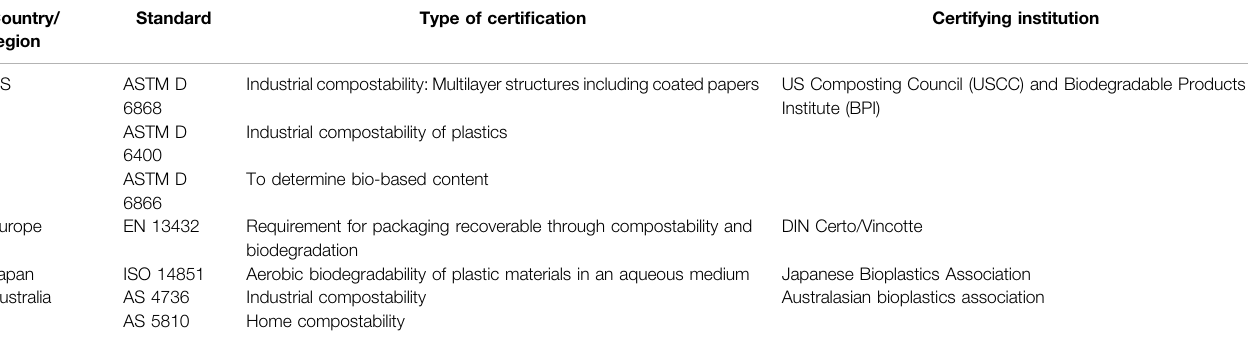
TABLE 1 | List of various composting certifying institutions and compostability standards. Country/